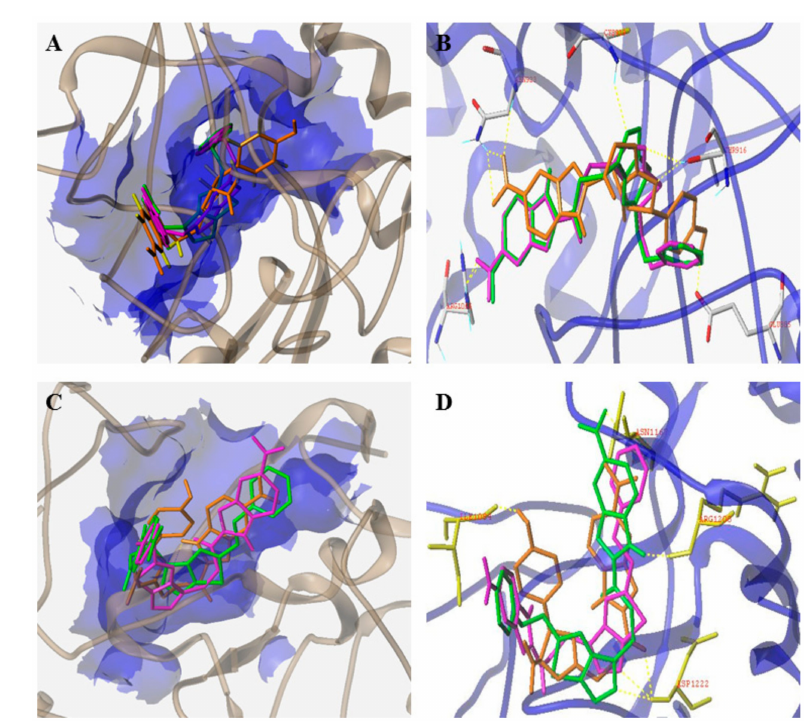
Figure 9. ( A , B ) The model of compounds 15 (magenta), 16 (green) and 17 (orange) bound to VEGFR-2 (PDB code: 2QU5); ( C , D ). The model of compounds 15 , 16 and 17 bound to c-Met (PDB code: 3CD8).